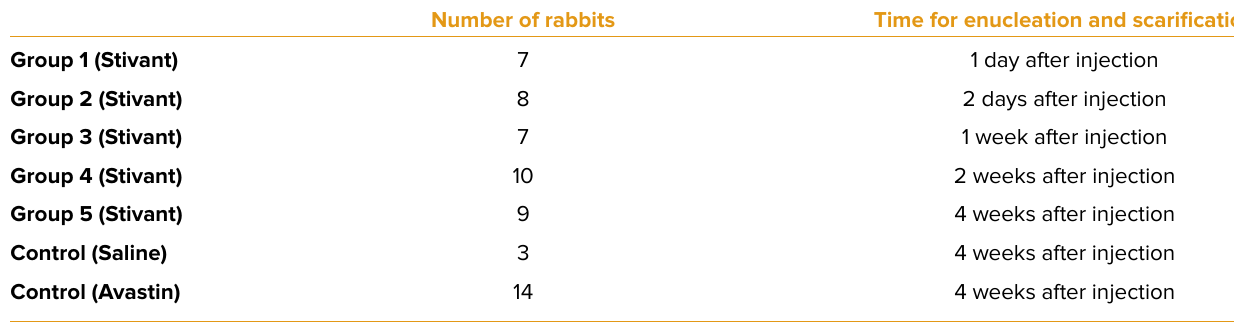
Table 1. Number of rabbits in each group